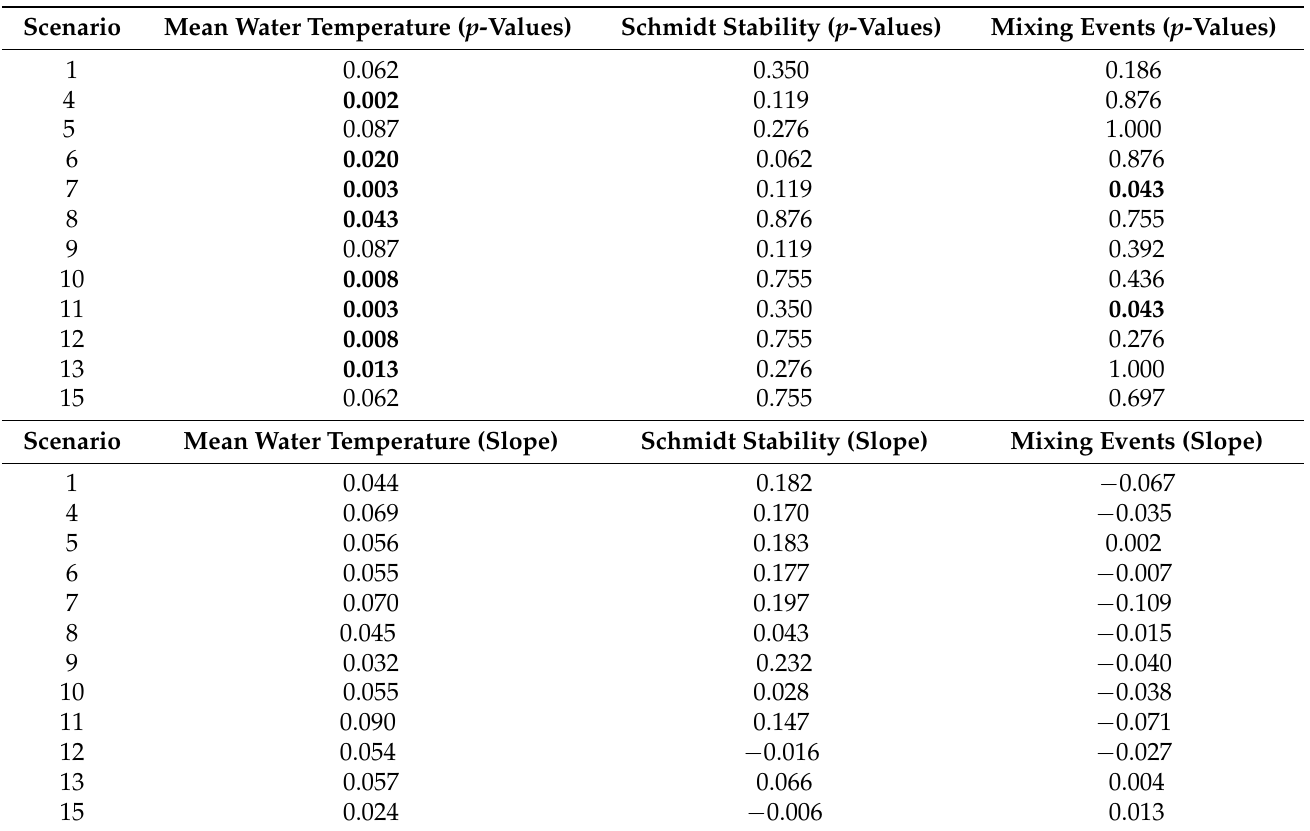
Table 2. p -values (calculated with the Mann-Kendall test) and slope of fitted linear trend for mean water temperature, S and mixing events from the 12 different climate scenarios across the range of years the model was run for. Bold text shows statistically significant p -values of below 0.05, indicating a relationship between the modelled parameters and time not likely attributed to